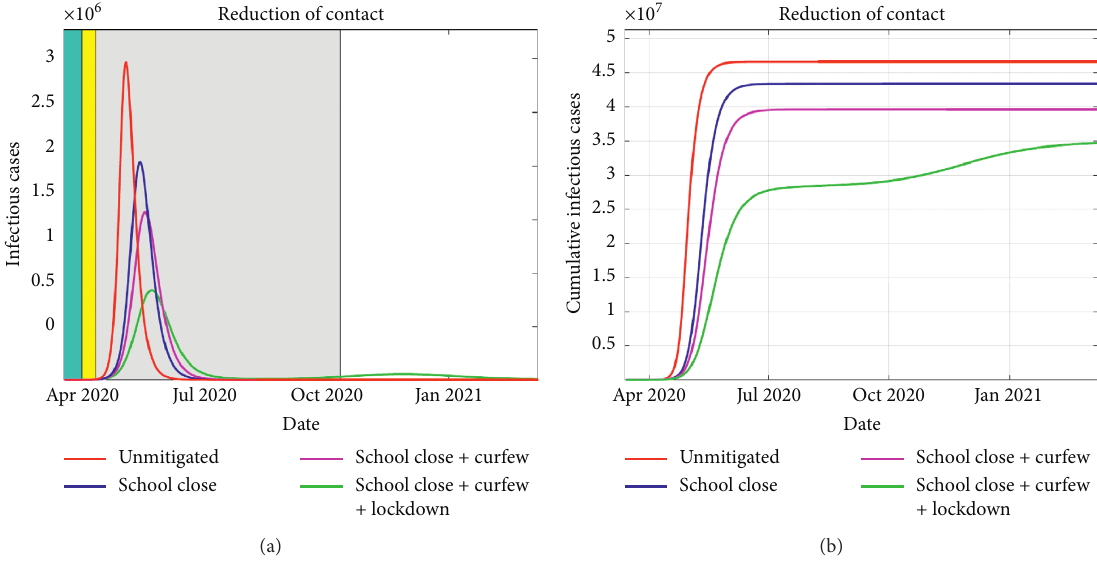
Figure 6: The simulated daily cases of infected individuals is shown in (a), whereby the duration of NPIs implementation is also indicated by the colored regions. The cumulative cases of the infected individuals are depicted in (b). The NPIs are shown to effectively mitigate the spread of the epidemic in the population. A combination of the three measures is the most effective strategy in that even though a new wave of infection emerges, it flattens out with a much lower peak.